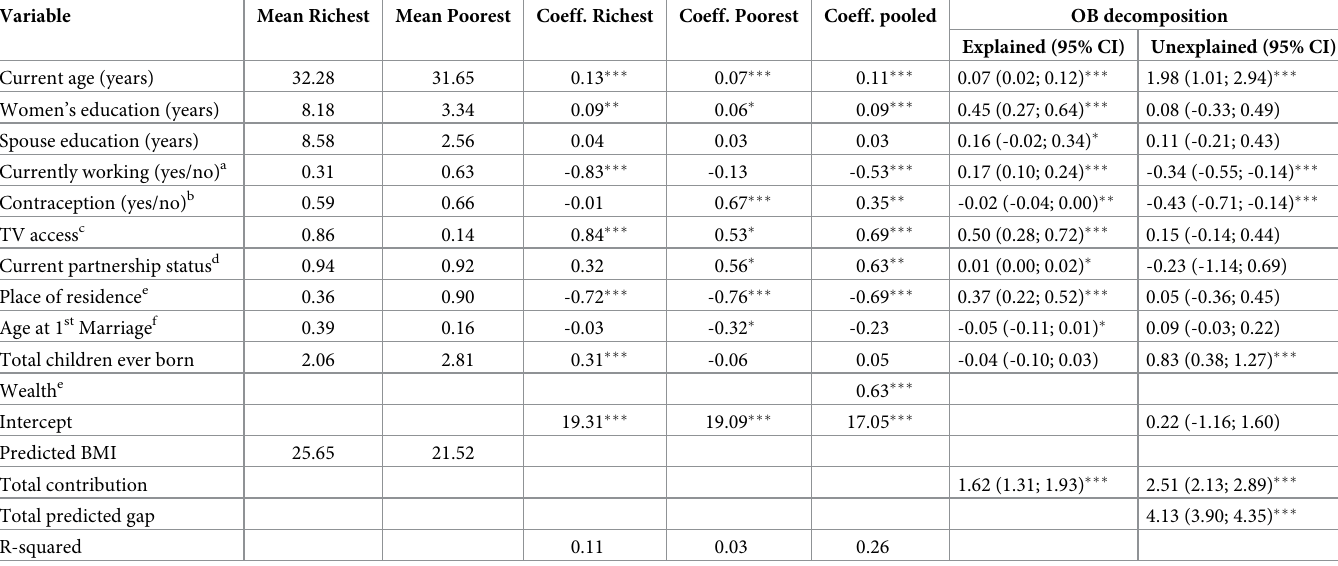
Table 3. Sample means, regression estimates, and decomposition results for the richest-poorest group of